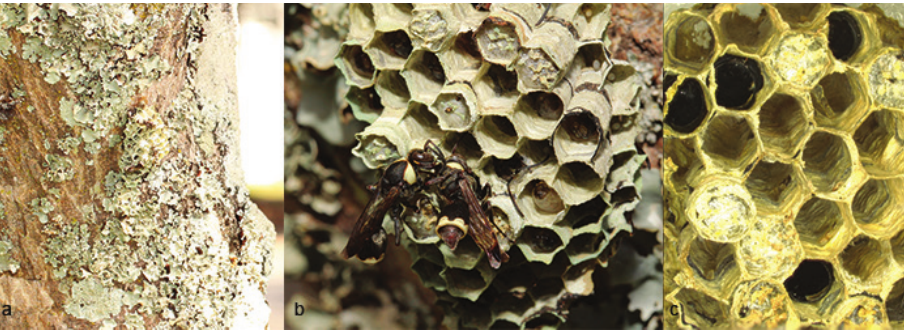
Figure 3. R. amabala sp. nov., nest a general appearance on a tree trunk b nest with wasps and closed cocoons c dried nest, with four tachinid